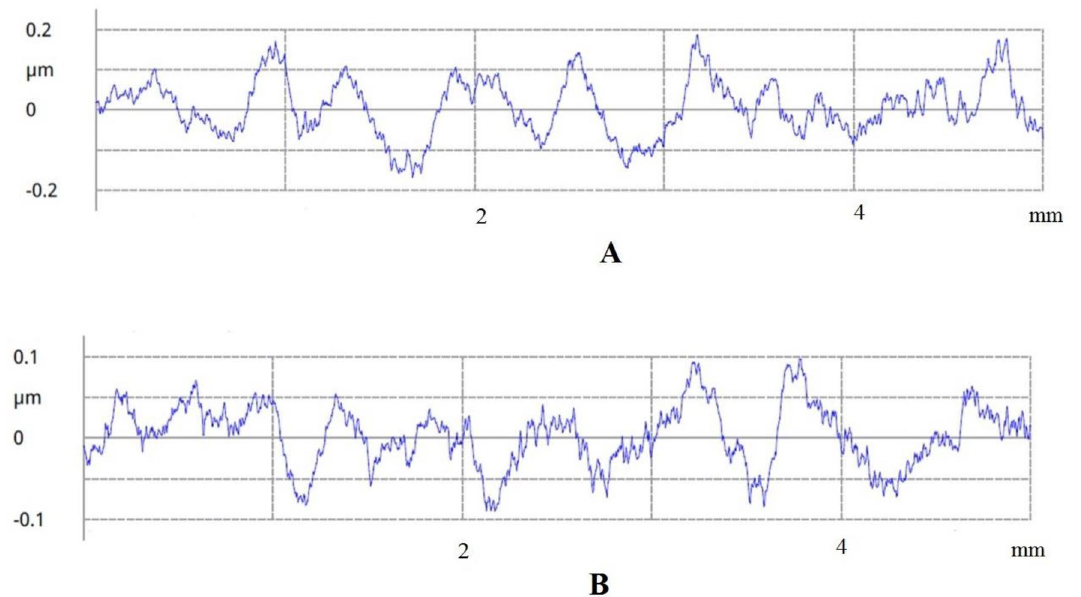
Fig. 21 Surface roughness profile of channels created in conditions of U = 38 V, NaOH-25%, zero rotational speed and feed rates of a V = 0.6 mm/min and b V = 1.2